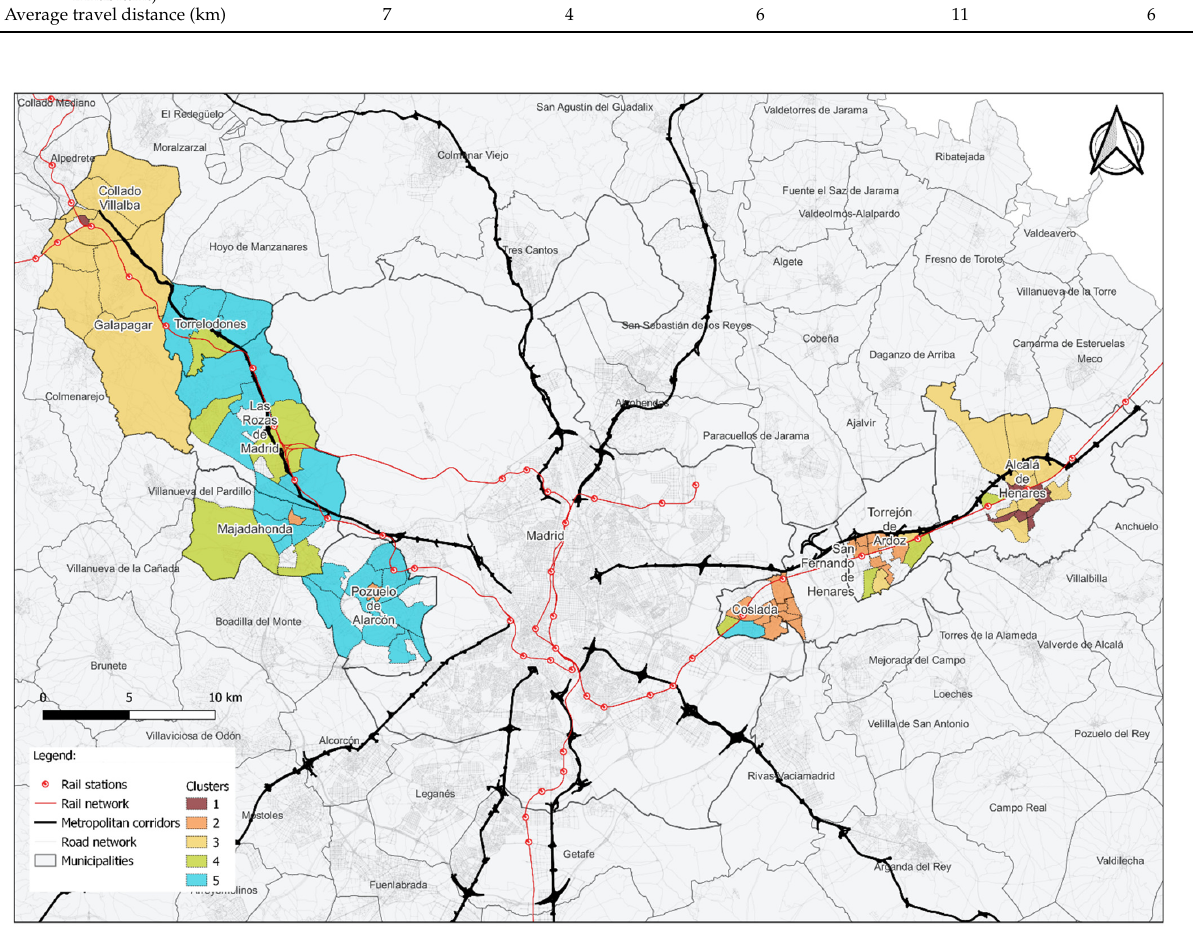
Figure 3. Clusters geographically mapped in the two corridors (A-2 and A-6). (QGIS